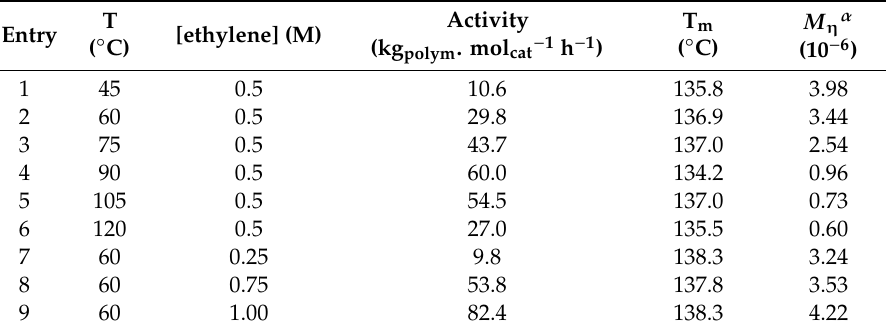
Figure 8. Molecular structure of 23 [13]. Table 7. Polymerization of ethylene catalyzed by 23 / MAO